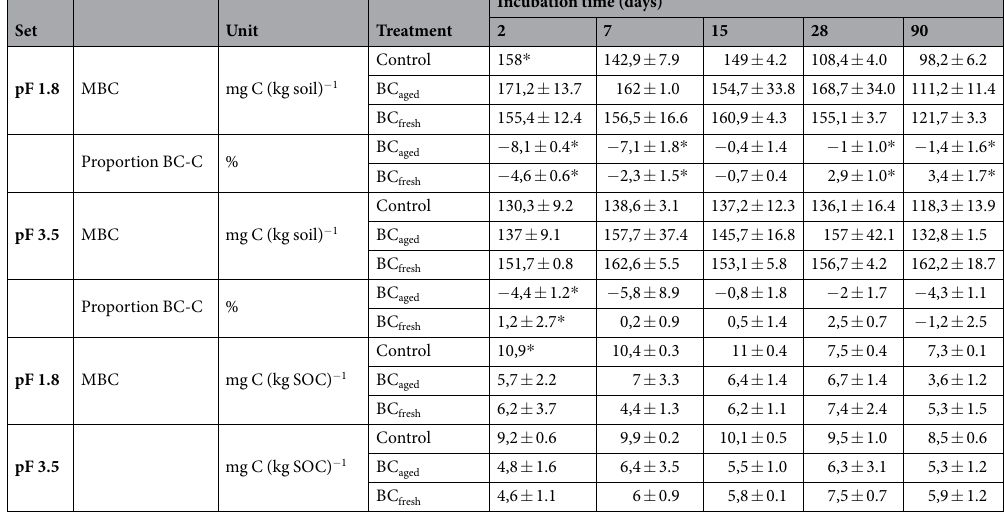
Both amendments increased native SOC mineralization (Fig. 3b). The highest native SOC losses were found at optimum water conditions for BC aged (896.3 mg C g − 1 soil). This corresponds to a positive priming effect leading to 21% increased native SOC mineralization with regards to the control. The addition of BC fresh induced a lower priming effect corresponding to 8% increase of native SOC mineralization as compared to the control. Under drought conditions, the increase of native SOC mineralization was even higher, with BC aged leading to 59% and BC fresh to 22% more native C loss compared to the control. The BC-C contributions to the respired CO 2 -C were higher under drought than under optimum conditions (Fig. 3c). Biochar derived C in BC aged soils accounted for 3.5% (pF 1.8) and 5.9% (pF 3.5) and in BC fresh soils for 5.6% (pF 1.8) and 8.8% (pF 3.5) of the total mineralized C, over the 90 days of incubation period. However, low amounts of BC-C were mineralized during the 90 days of incubation. Less than 0.5% of BC-C was respired. Higher BC-C proportions were respired in soils containing BC fresh (0.3% of BC-C) than in soils containing BC aged (0.2% of BC-C). Despite a ‘BC-C flush’ at pF 1.8 after BC fresh addition at the beginning of the experiment (Fig. 3c), the mineralization of both BC types differed only marginal after 90 days. 171.2 ± 13.7 mg kg − 1 soil at the beginning of the experiment. After 90 days of incubation, microbial biomass decreased in all treatments and ranged between 98.2 ± 6.2 mg kg − 1 soil and 121.7 ± 3.3 mg kg − 1 soil. Similar values were recorded for drought conditions (Table 3). Between the start and the end of the experiment, the microbial biomass of BC amended soils decreased by 35% and 38% at pF 1.8 (aged and fresh), whereas it remained rather constant at pF 3.5. The δ 13 C abundance in the fumigation extracts from control, BC aged and BC fresh were very similar resulting in high uncertainties for the calculation of the BC-C proportion (Table 3). Within the first week of the incubation experiment, microbial biomass from all samples showed a depletion of 13 C to differing degrees (up to 8.1 ± 0.4% for BC aged at pF 1.8). This effect leveled out with progressing time but microbial biomass in the treatments BC aged remained depleted in 13 C at both water potentials compared to the control after 90 days of incubation. BC fresh showed 3.4 ± 1.7% incorporation of BC derived C into microbial biomass under optimum conditions, whereas under drought, BC-C was not incorporated into the soil microbial biomass. The metabolic quotient (qCO 2 ) of the control soils decreased during incubation from 3.56 to 2.95 mg CO 2 -C g − 1 biomass C h − 1 under optimum water conditions and from 2.24 to 1.14 mg CO 2 -C g − 1 biomass C h − 1 under drought conditions (Fig. 4). Due to the CO 2 flush and consistent microbial biomass C in the first week, the qCO 2 increased in all treat- ments. In drought-affected soils, only BC aged addition had an effect on qCO 2 . The qCO 2 of soils containing BC fresh remained similar to the qCO